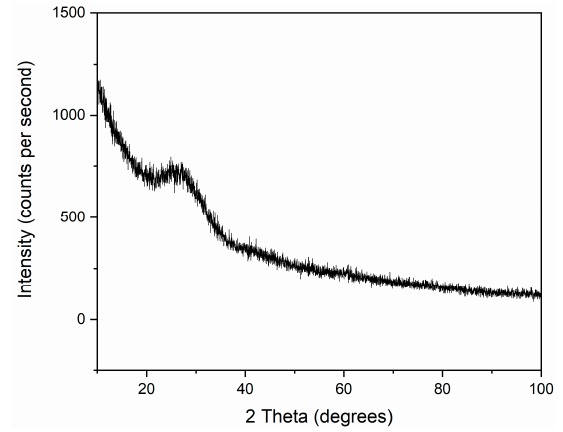
Figure 8. ( a ) Photo and ( b ) scanning electron microscope (SEM) micrograph of printed and sintered glass sample. Materials 2019 , 12 , x FOR PEER REVIEW 11 of 13